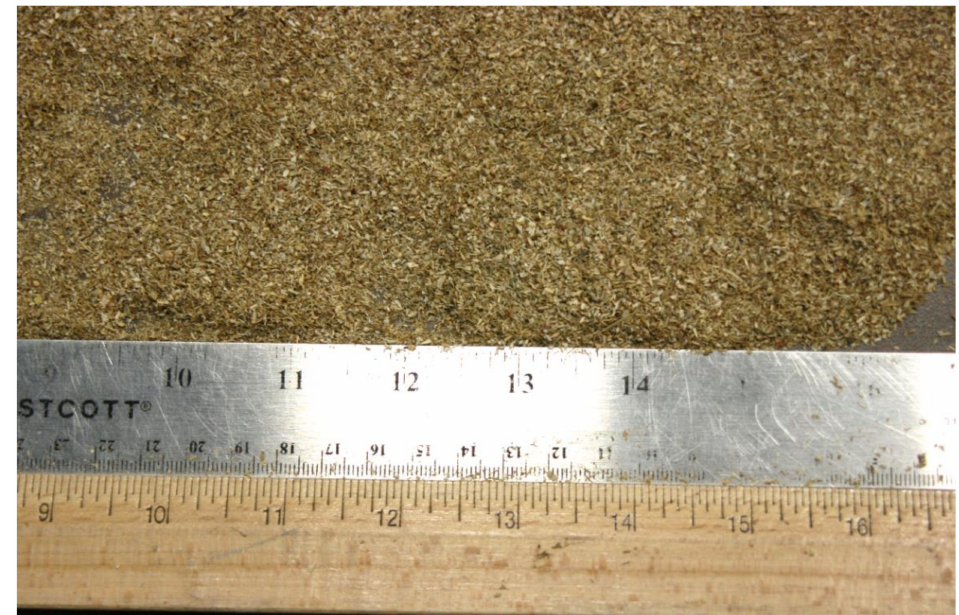
Figure 6. The corn stover after passing through the Wiley